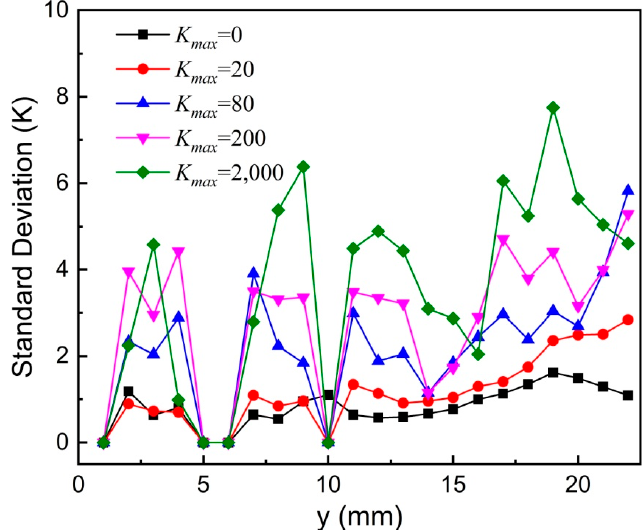
Figure 9. Standard deviation of measured temperature versus y position for different K max values. Symbols represent experimental results whereas solid lines are guides to the eye.